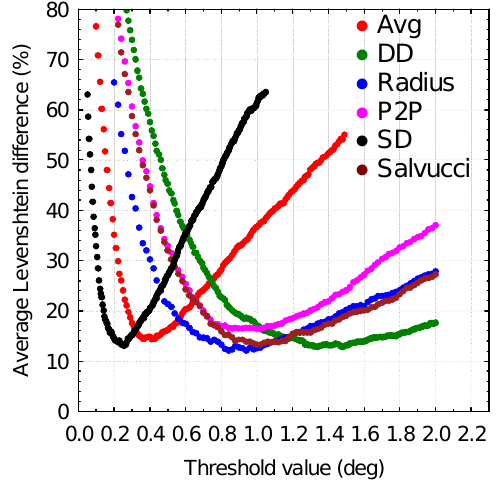
Figure 9. Average Levenshtein distance for all participants against threshold value Table 1. Minimum average Levenshtein distance and corresponding threshold